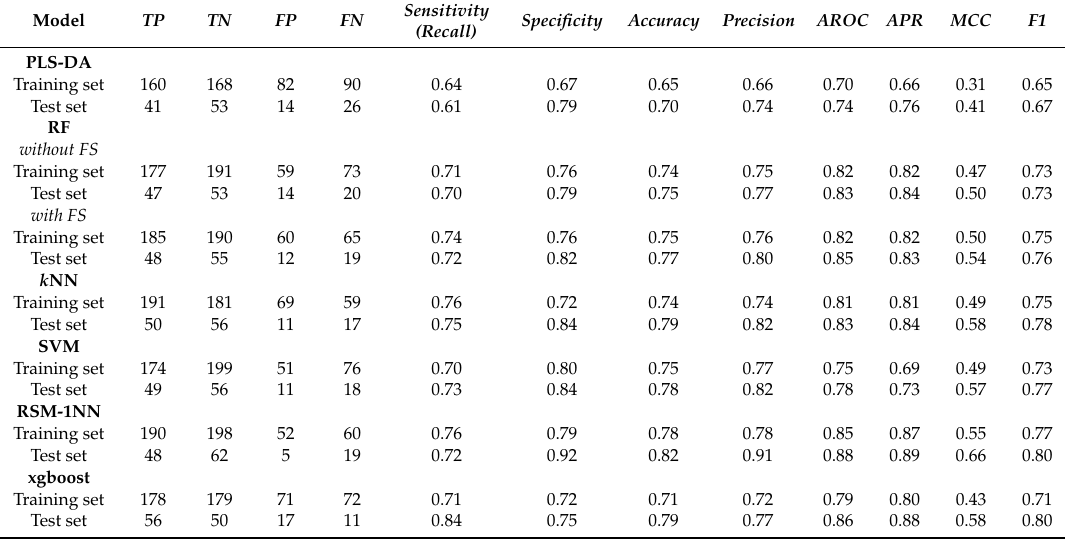
Table 1. Summary of the performance of the machine learning (ML) models. TP —true